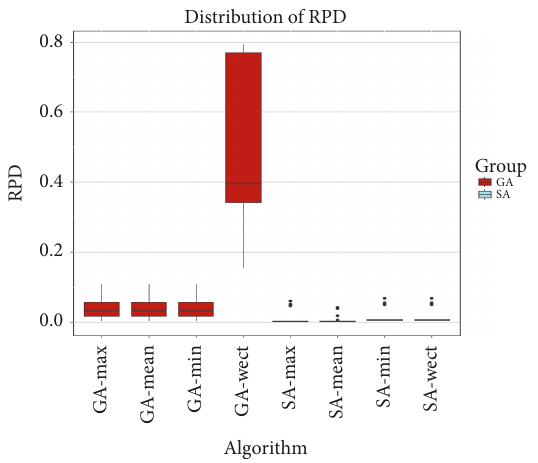
Figure 7: Box plots of RPD for the algorithms for large number of